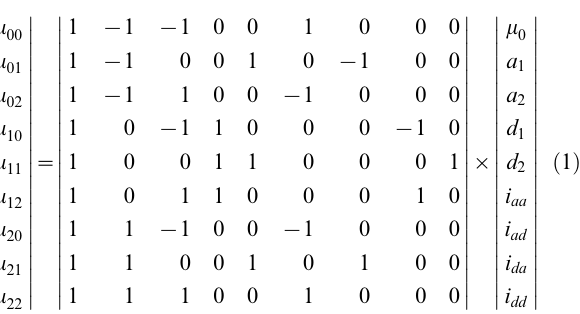
Mather and Jinks’ theory is used to formulate the relationships between genotypic values and genetic effects, expressed as